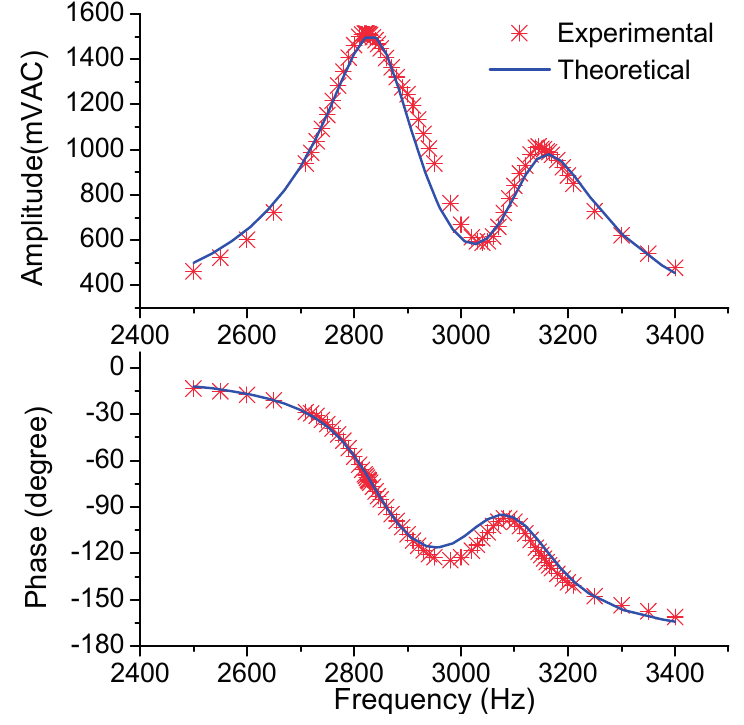
Figure 13. The measured frequency response and the theoretical response of the sense